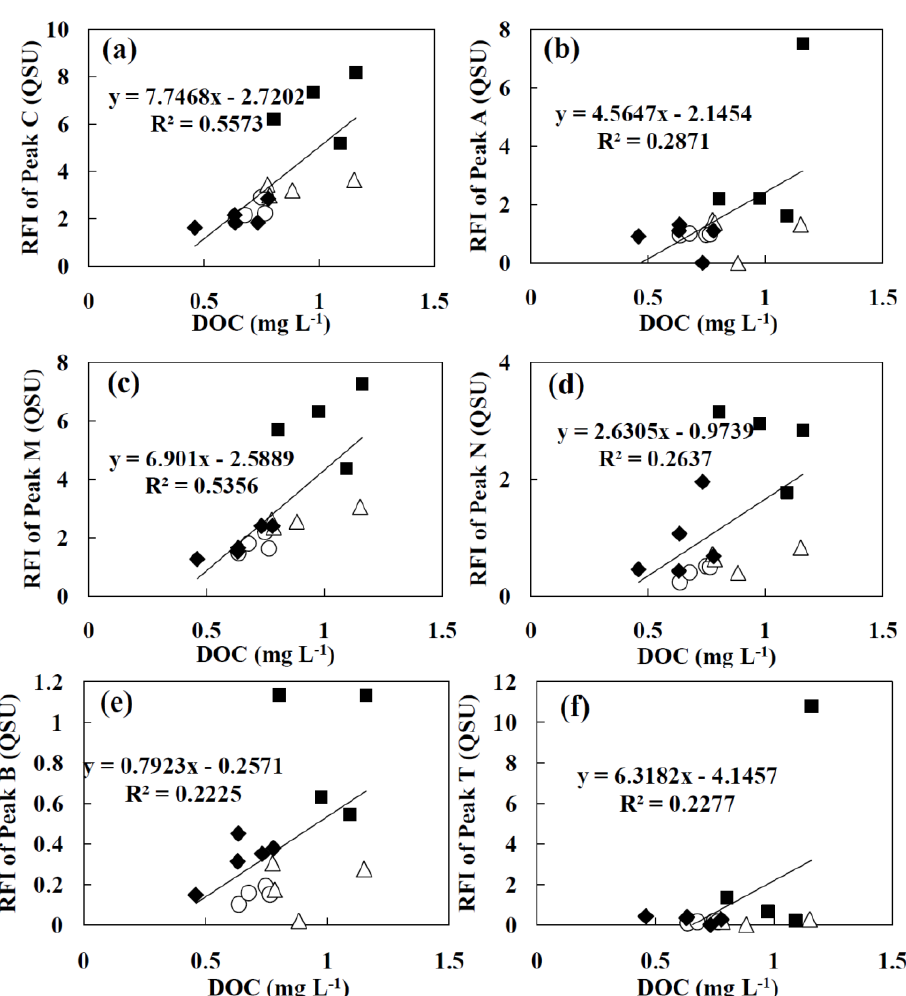
Figure 5. Relationship between fluorescence intensity of ( a ) peak C; ( b ) peak A; ( c ) peak